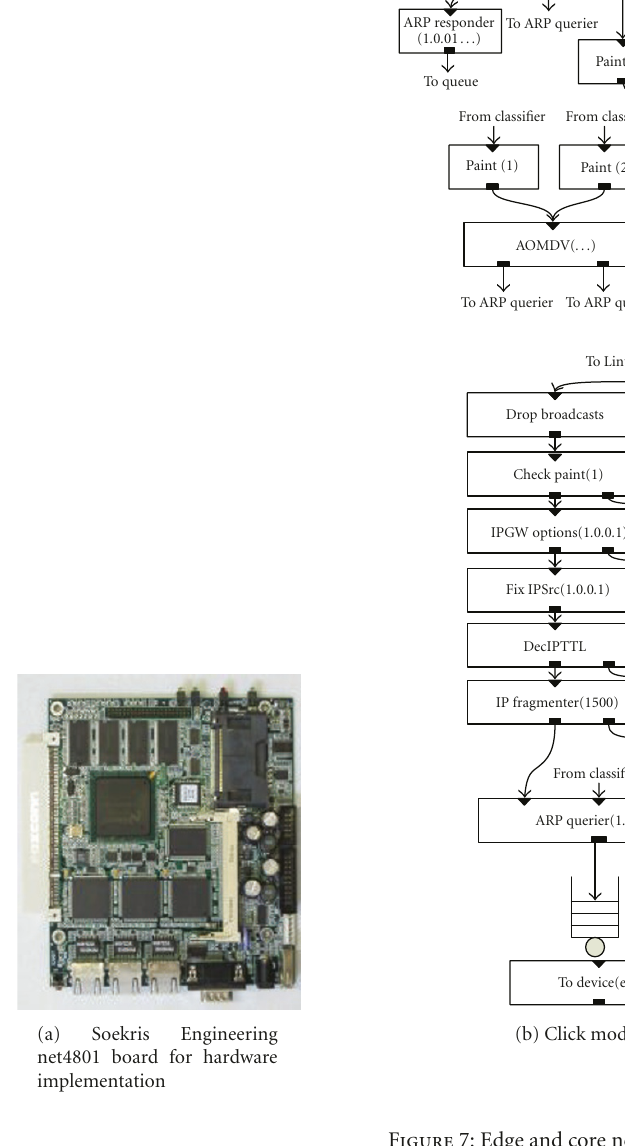
Figure 7: Edge and core node